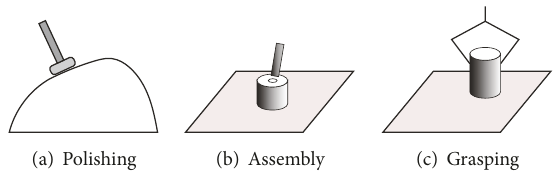
Figure 3: Typical examples of force-relevant skills, including pol- ishing, assembly, and